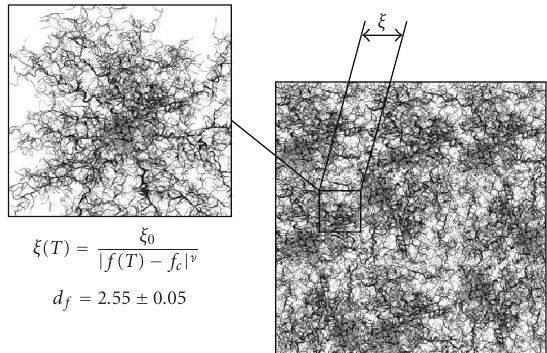
Figure 13: Schematic representation of the dynamic homogeneous fractal structure of an amorphous material near the glass transition temperature. Below the T g , the correlation length gives characteristic sizes of clusters made of configurons, whereas above the T g , it shows characteristic sizes of clusters made of unbroken bonds. The higher the temperature is, the smaller sizes of fractal volumes are. Note that the structure shown is dynamical, for example, changes with time due to configuron di ff